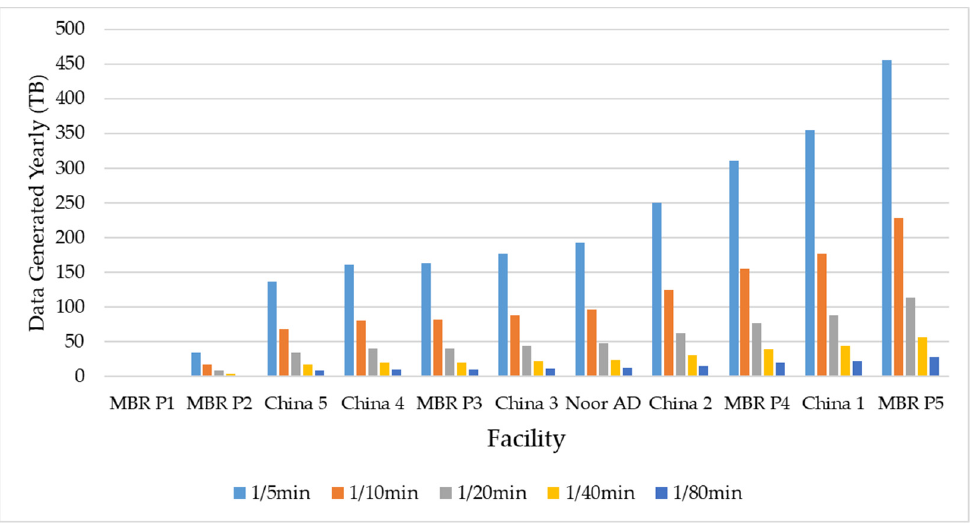
Figure 16. Estimated data generated by each facility per year for different reporting frequencies.